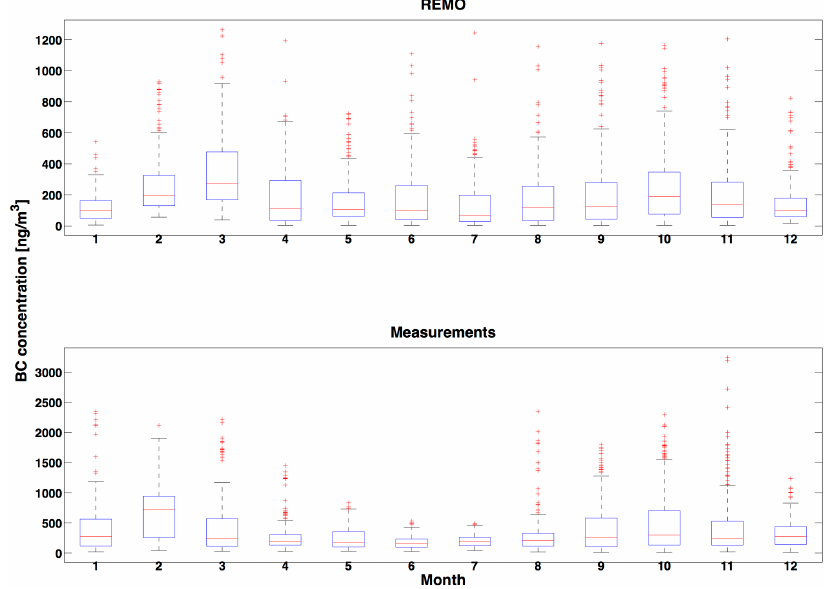
Fig. 4. The box-and-whisker diagram of the model (upper panel) and measurements’ (lower panel) BC concentrations in Hyyti¨al¨a (2005). The solid red line locates the median, the edges of the box are the 25th and 75th percentiles and the red plus marks represent the